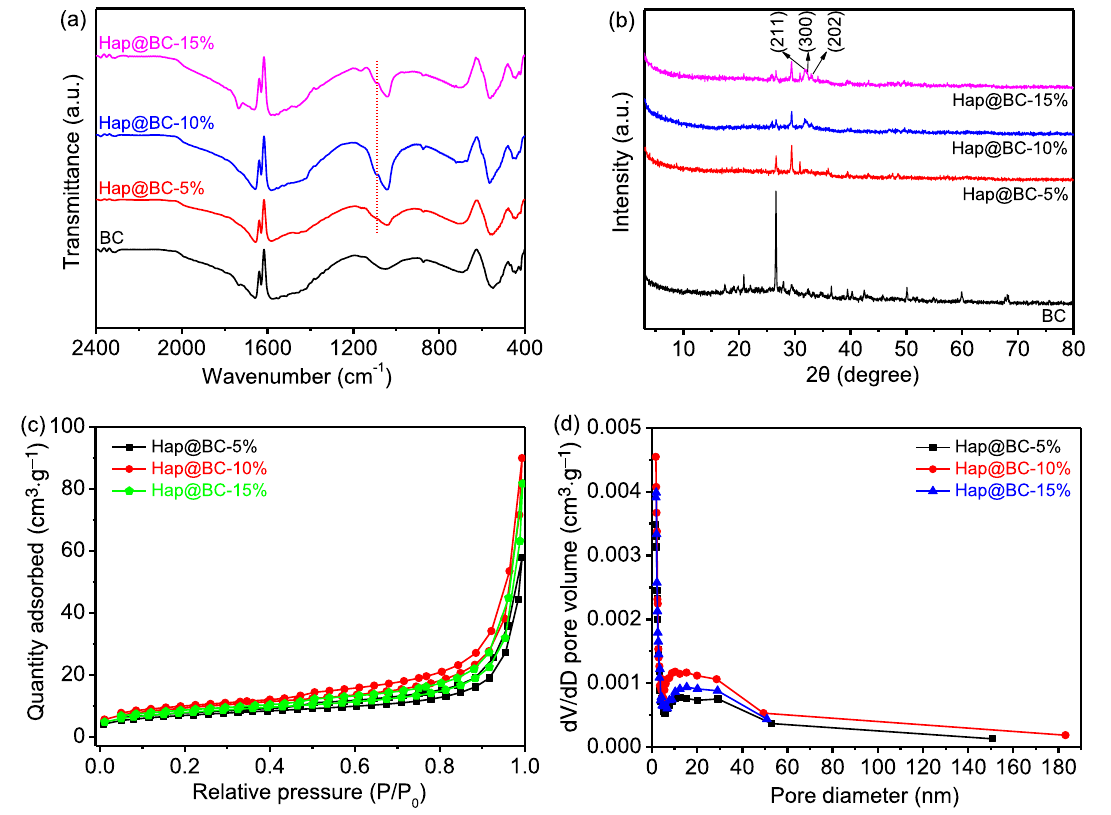
Fig. 1 a FTIR spectra, b XRD patterns of BC, Hap@BC-5%, Hap@BC-10% and Hap@BC-15%, c N BJH pore size distributions of Hap@BC-5%, Hap@BC-10% and